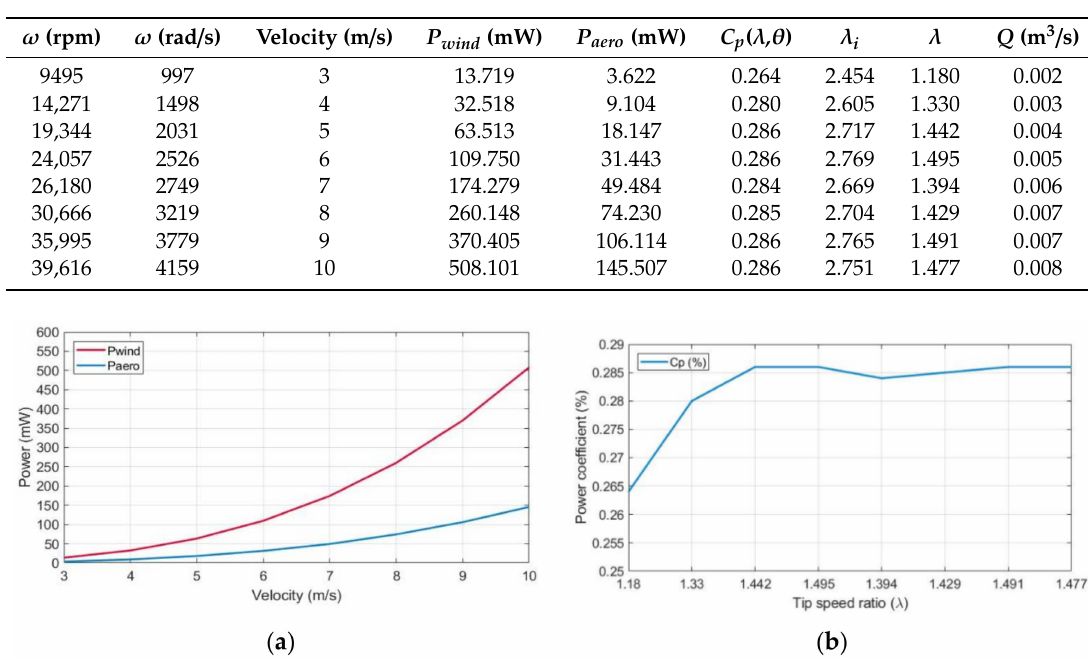
Table 3. Wind and mechanical calculated values at open space condition.